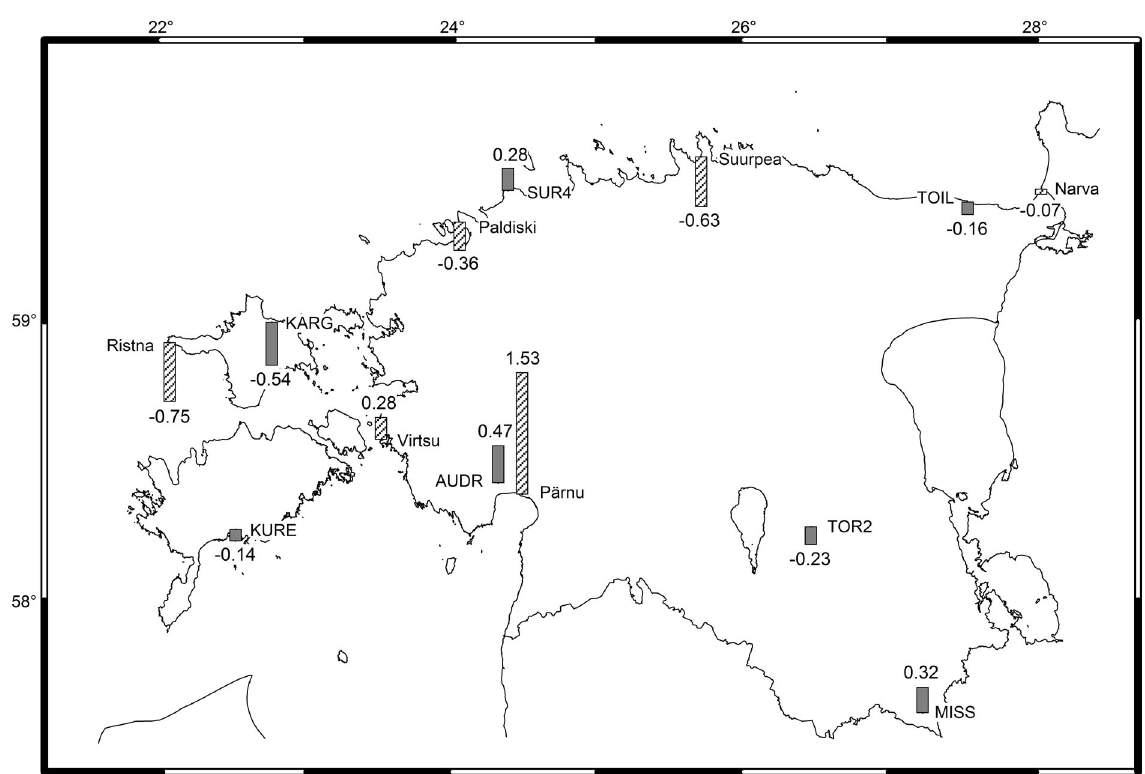
Fig. 6. Residual vertical velocities (VVs, in mm yr –1 ) (observed–interpolated) from the comparison of the GNSS-based (grey bars) and tide gauge and satellite altimetry (TG & SA)-based absolute VVs (patterned bars) with the apparent VVs interpolated from the EST2015LU model (Fig. 4). The root mean square values of the residual VVs were  0.34 mm yr –1 (GNSS) and  0.76 mm yr –1 (TG & SA;  0.48 mm yr –1 without